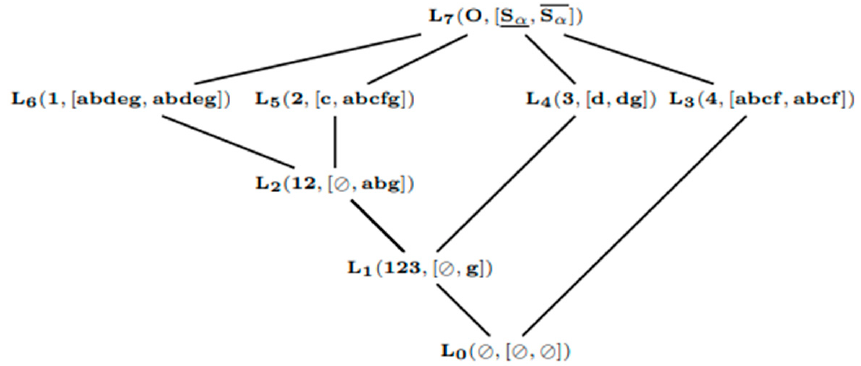
Figure 2. Illustrates the Hasse diagram From Table Figure 2. From Table 2.